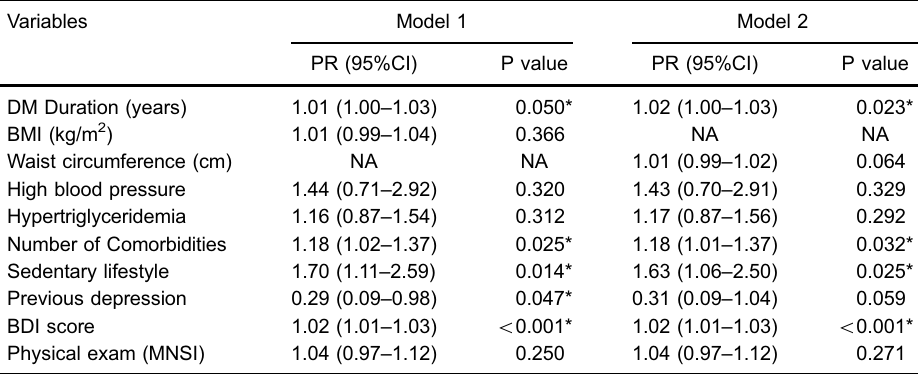
Table 4 . Multiple Poisson regression analysis performed to evaluate factors independently associated with the symptom of unsteady walking (UW).